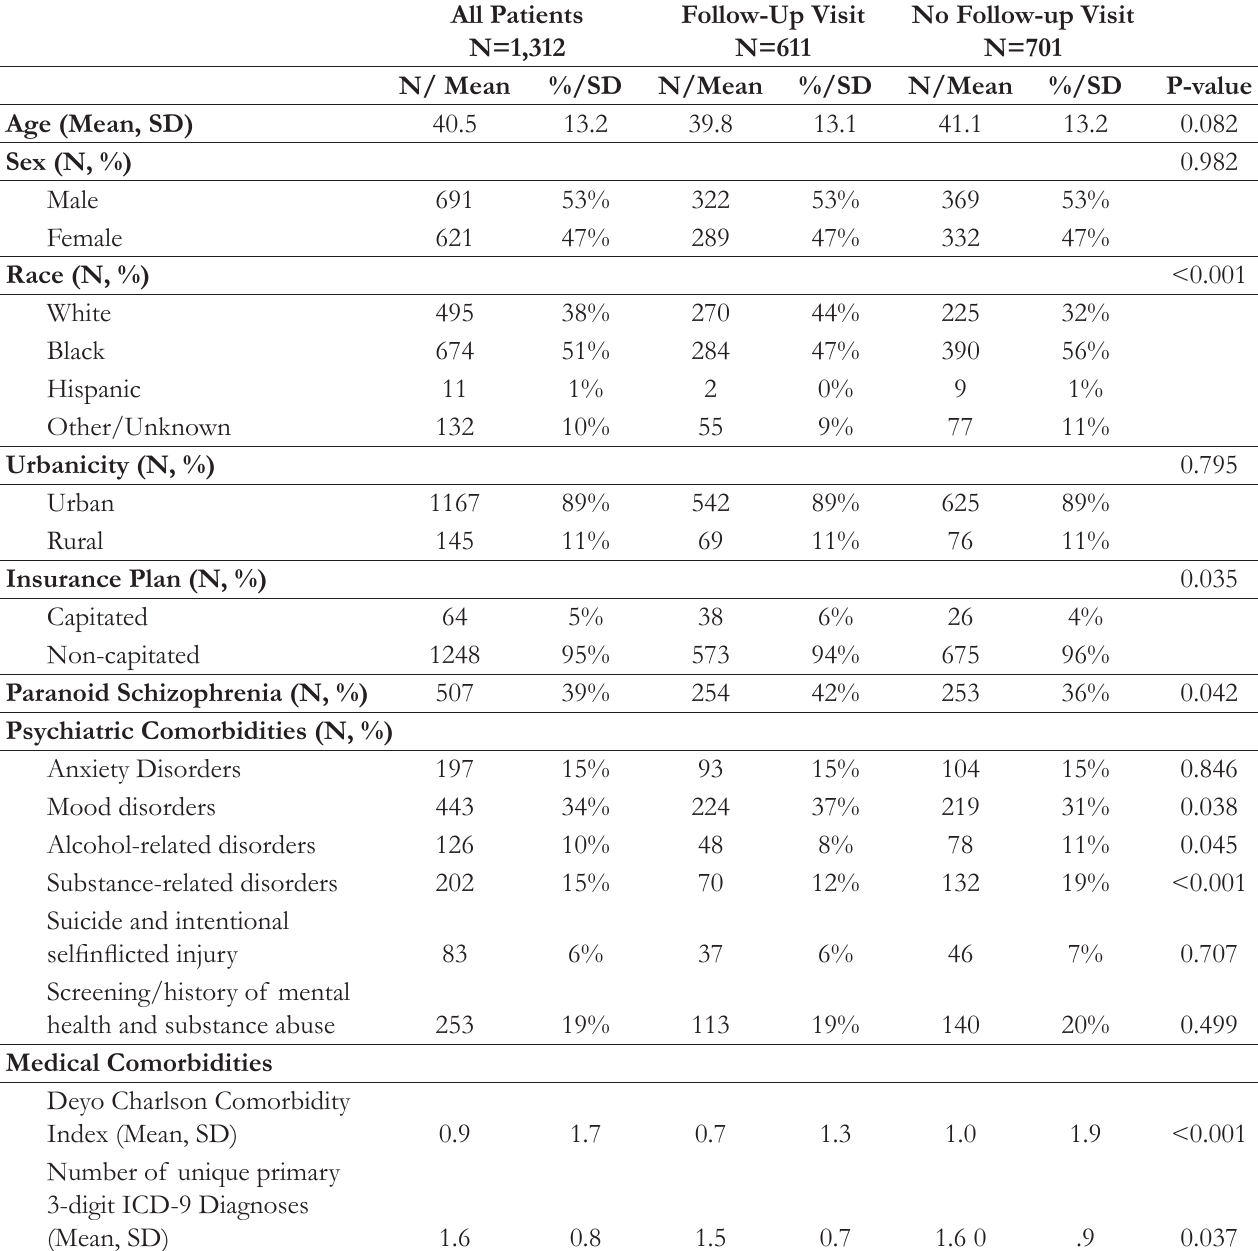
Table 1. Demographic and Clinical